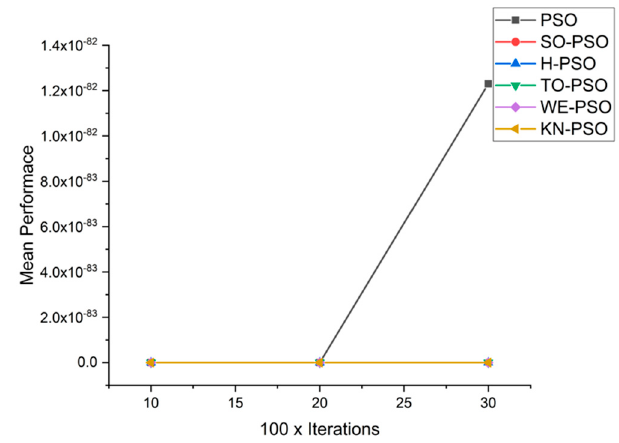
Figure 13. Convergence curve on fn7.